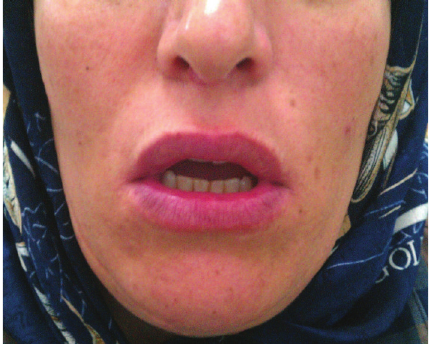
Figure 3: After 2-month follow-up (lesions resolved). Figure 4: After one-year